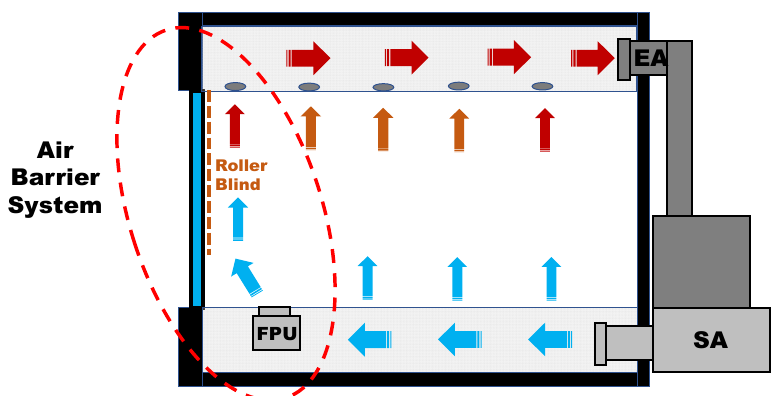
Figure 1. Air barrier system with the underfloor air distribution system.